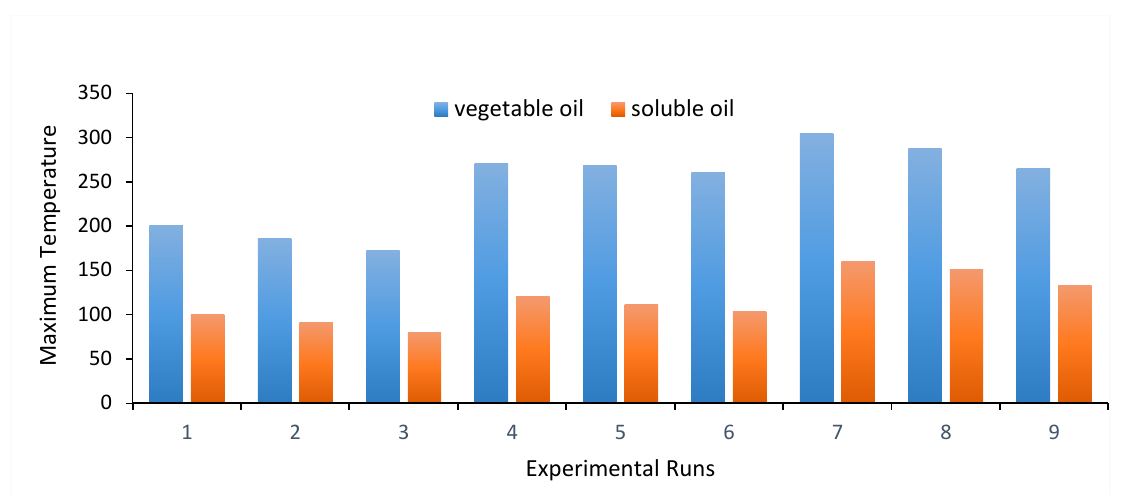
Figure 6: Maximum temperature attained during machining with various cutting